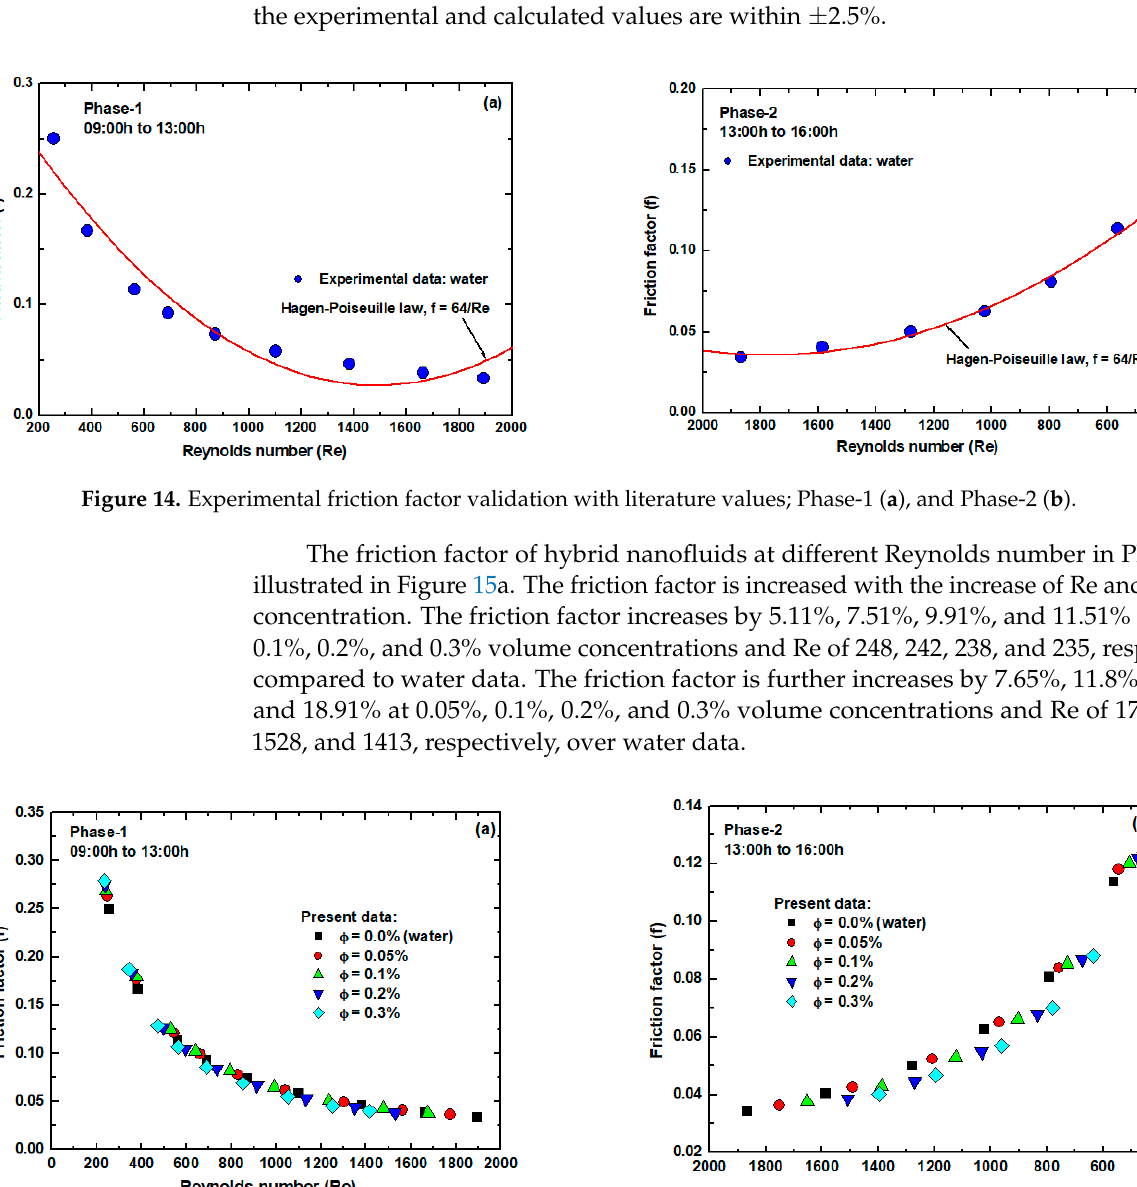
Figure 13. Experimental Nusselt number against proposed equation; Phase-1 ( a ), and Phase-2 ( b ).